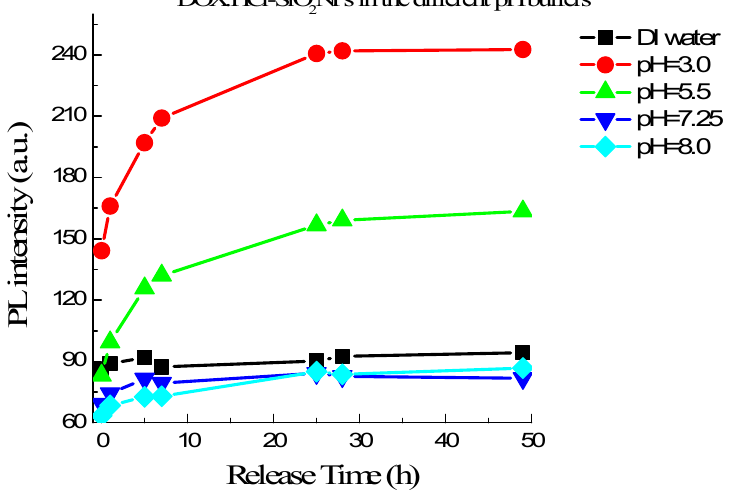
Figure 6. DOX · HCl release profiles from DOX · HCl-SiO 2 NPs in the different pH buffers varying Figure 6. DOX·HCl release profiles from DOX·HCl-SiO 2 NPs in the different pH buffers varying from 3.0 to 8.0 in from 3.0 to 8.0 in time.